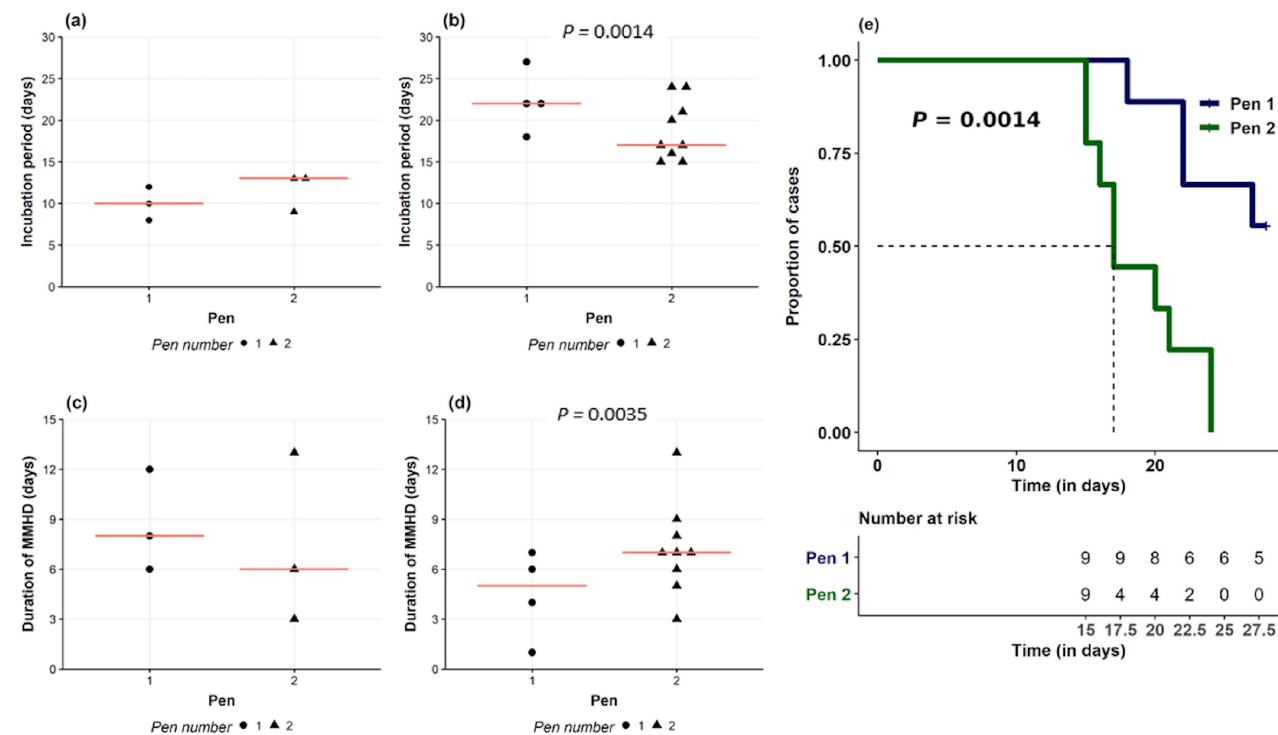
Fig 2. Trial 1 disease incubation, duration and survival in clinically affected seeder and contact pigs. (a) Incubation period in seeder pigs calculated pigs from intragastric inoculation with B . hampsonii to onset of mucoid or mucohemorrhagic (MMHD), (b) incubation in contact pigs calculated pigs from onset of natural exposure to seeder pigs to onset of MMHD. Duration of mucoid or mucohemorrhagic diarrhea (fecal score � 3) in clinically affected seeder (c) and contact (d) pigs. Median values are showed as a red horizontal line. (e) Kaplan Meier survival curve for time to presentation of MMHD in contact pigs in pens 1 (blue line) and 2 (green line). Each pen contained 9 contact pigs and 3 seeder pigs after regrouping (3:1 ratio). Statistical difference ( P < .05) is indicated by an asterisk ( �